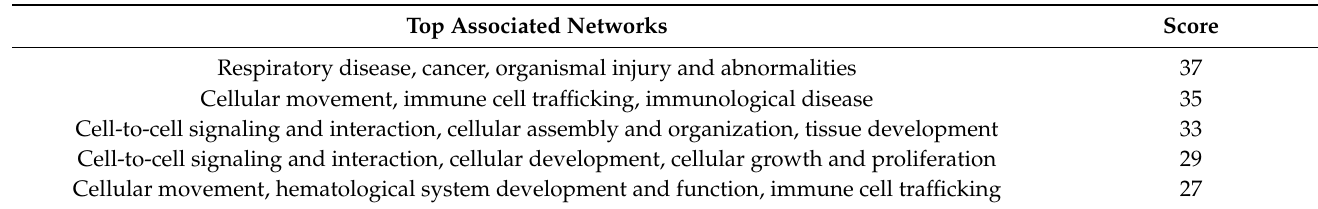
Table 5. IPA top associated networks based on miRNA–mRNA binding relationships. Top Associated